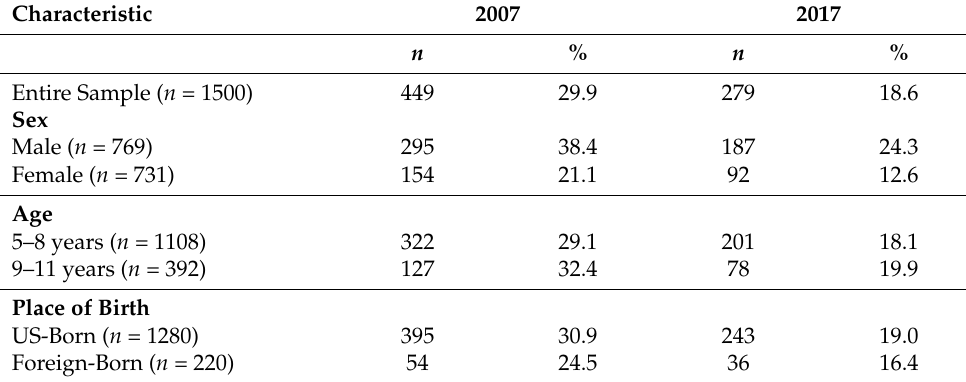
Table 2. Prevalence of overweight/obesity in 2007 and 2017 in the study sample.